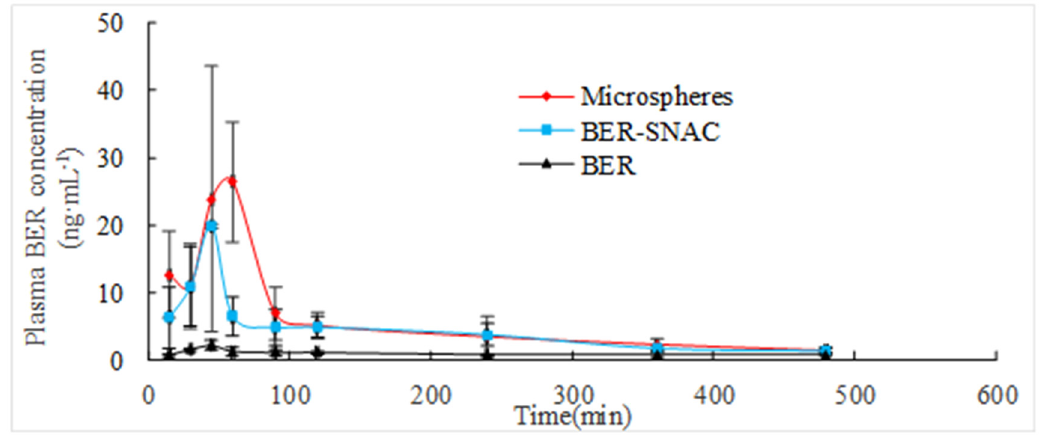
Figure 7. Pharmacokinetic profile for total berberine hydrochloride (BER) content vs. time in rats after oral administration of BER, BER mixed with sodium N -[8-(2-hydroxybenzoyl)amino]caprylate (SNAC), and BER-SNAC-loaded microspheres. Means ± S.D., n = 6.